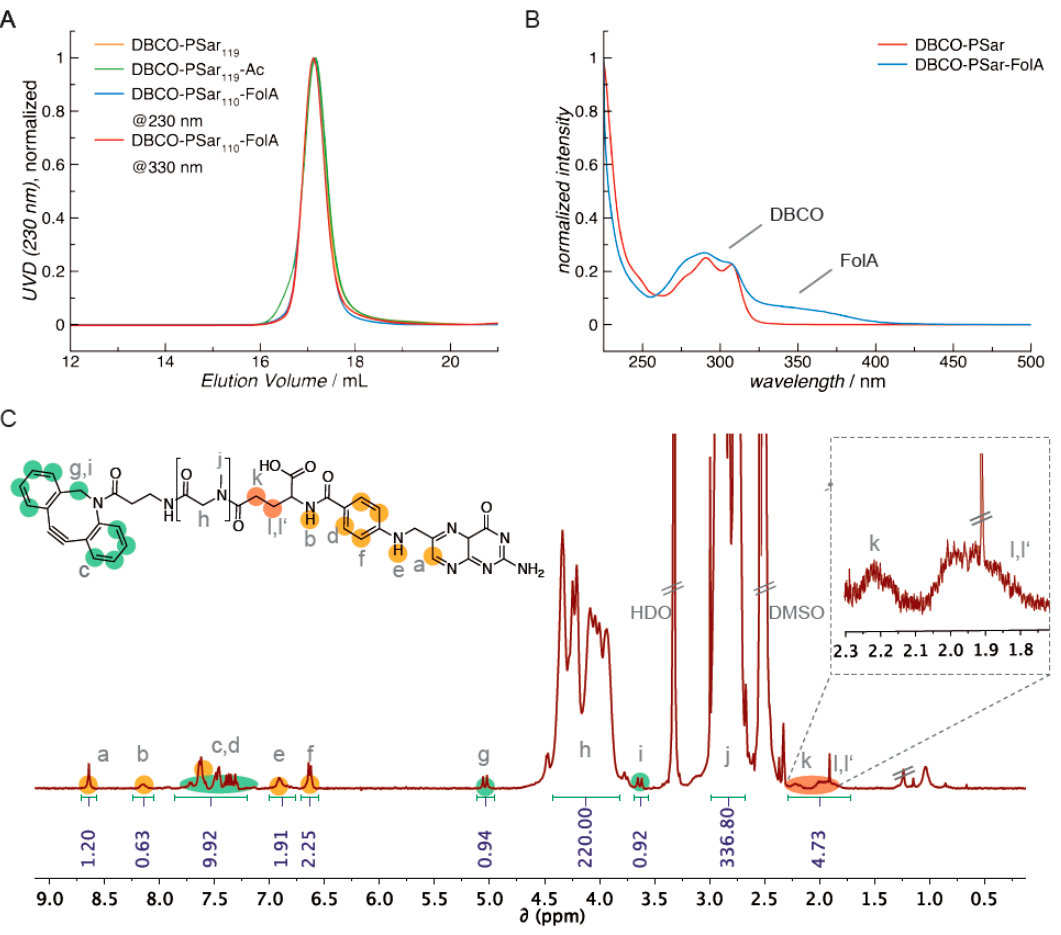
Figure 5. Characterization of DBCO-pSar ligands for post-shielding of polyplexes. ( A ) GPC elugrams of DBCO-pSar in HFIP with different end groups; ( B ) UV-vis spectrum of DBCO-pSar and DBCO-pSar-FolA, respectively; ( C ) 1 H NMR spectrum of DBCO-pSar-FolA in DMSO- d6 (400 MHz).